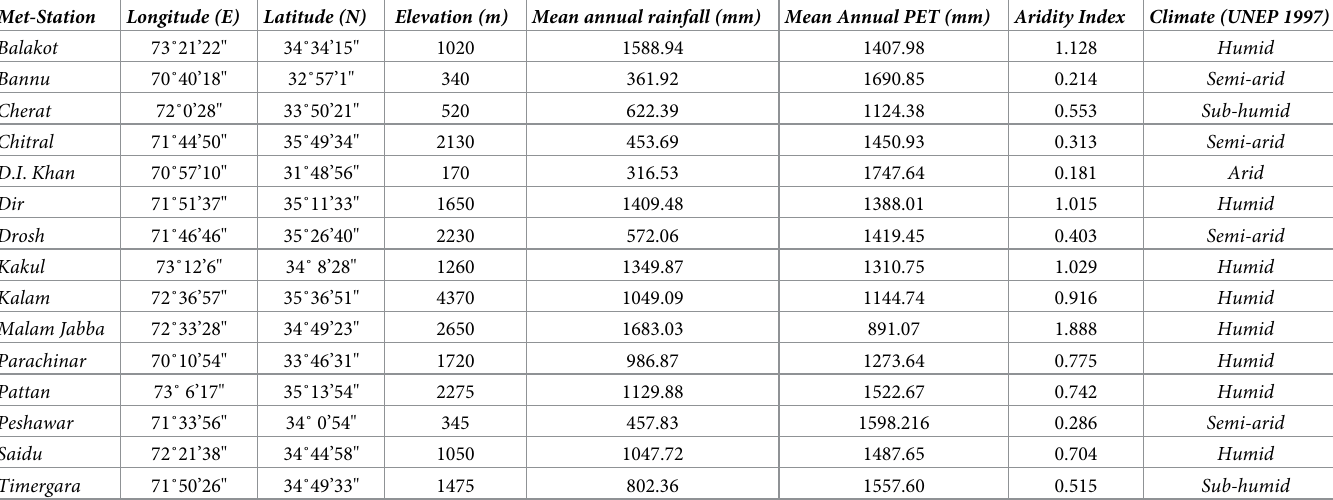
Table 2. Khyber Pakhtunkhwa, geographic and climatic characteristics of met-stations.